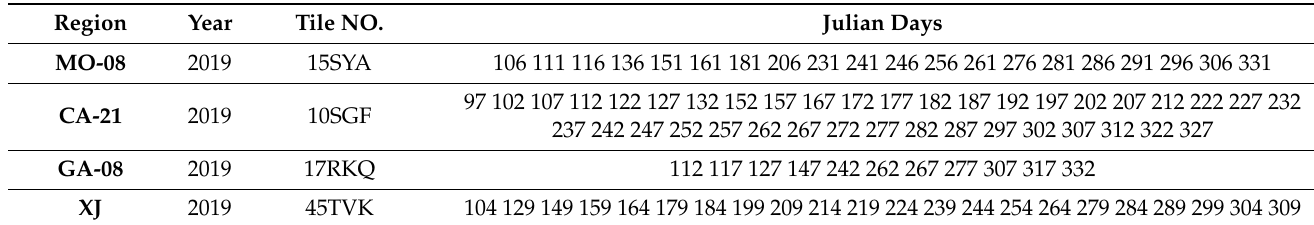
Table 2. Sentinal-2 time series used in study areas.